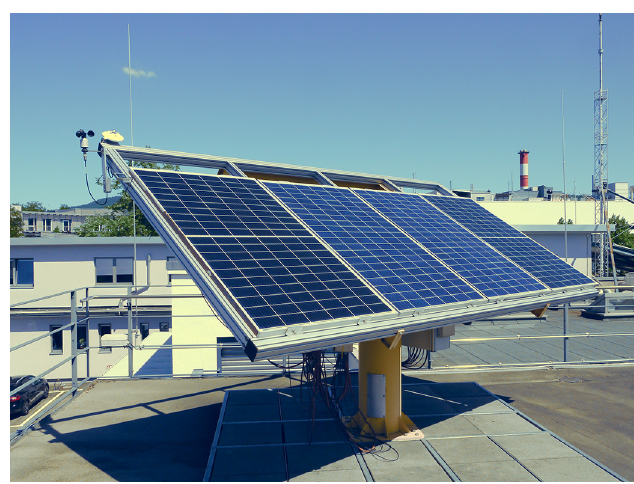
Fig. 3. PV modules on a two-axis tracker, which is used for the LETID outdoor test.